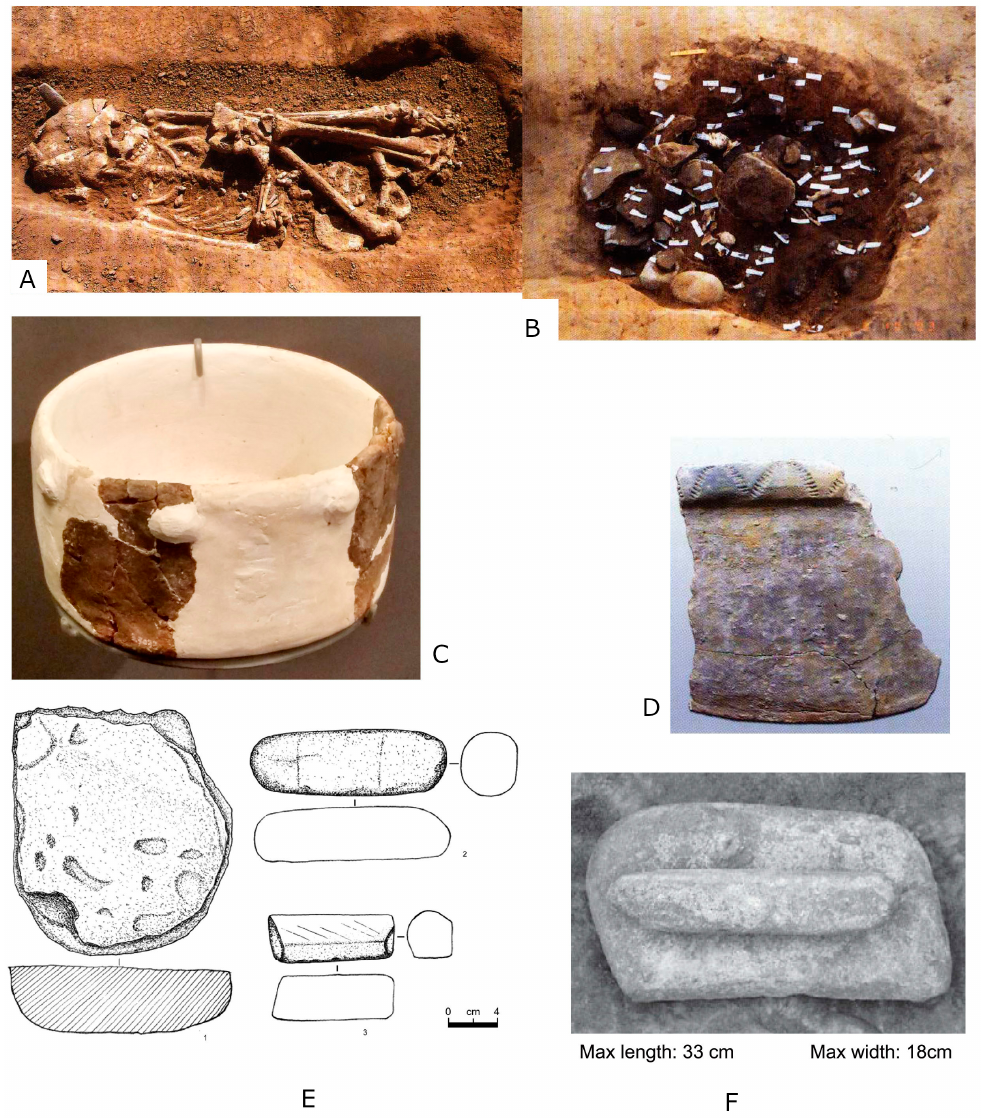
Figure 3. Features and artifacts found from transitional sites (11.5–8.5 ka BP) which show the innovative cultural traits that herald the “Neolithic package” and differ from typical Paleolithic remains (( A ): sedentary burial, Donghulin site (2 in Figure 1); ( B ): stone-lined hearth, Donghulin site (2 in Figure 1); ( C ): Pottery bowl, Zhuannian site (1 in Figure 1); ( D ): pottery sherd with decorations on the rim, Donghulin site (2 in Figure 1); ( E ): stone slab and rollers Bianbiandong site (7 in Figure 1); ( F ): stone slab and roller, Donghulin site (2 in Figure 1), the maximum length and width are marked in the graph, after [37,38,43]).